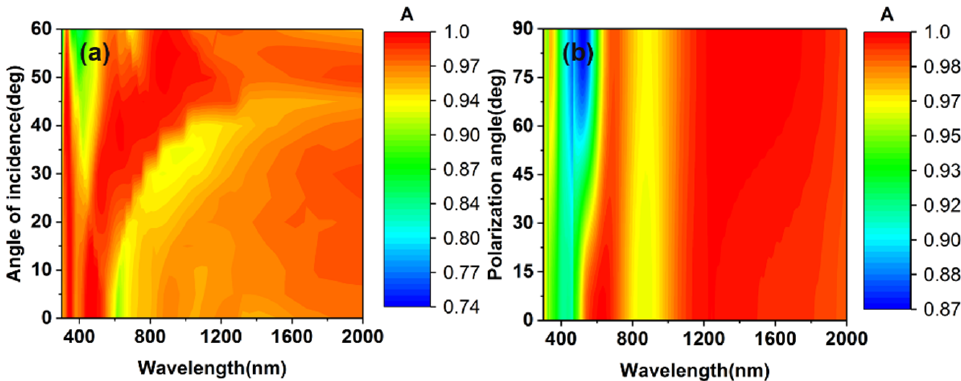
Figure 11. ( a ) The evolution of absorbers’ absorption as the incident angle increases from 0° to 60°. ( b ) The evolution of absorbers’ absorption as the polarization angle increases from 0° to 90°. To verify the final effect of the absorber, the distribution of absorbed solar spectral power density is calculated based on the standard solar radiation spectrum AM 1.5. As shown in Figure 12a, the black spectrum is the standard solar radiation spectrum of AM 1.5, and the red line represents the absorption spectrum of the absorber. It is straightforward that the absorber maintains strong absorption characteristics in the full spectrum range. The absorber presents a perfect absorption, especially in the range of which the wavelength is longer than 1200 nm. Figure 12b shows the total absorbed power and the energy missed.